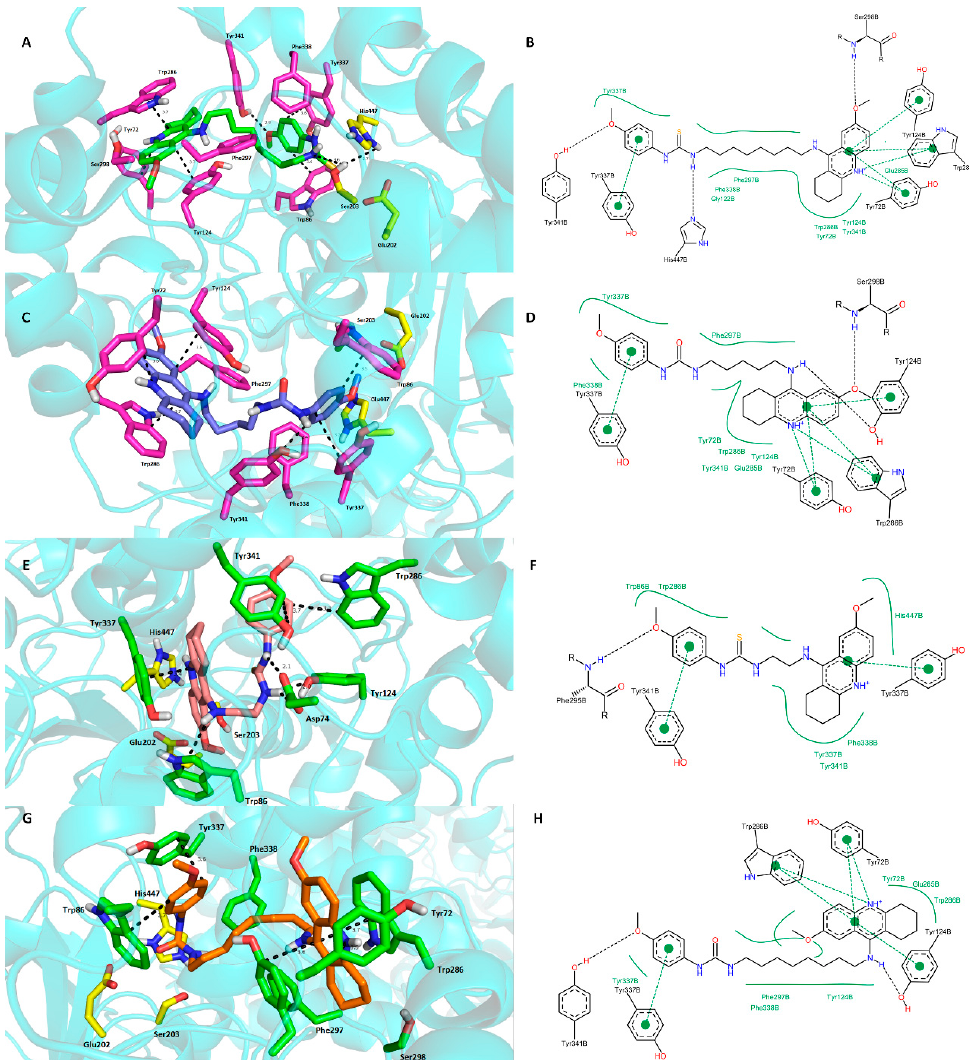
Figure 4 . Docking results for the novel 7-MEOTA- p -anisidine hybrids ( 9 , 15 , 19 and 22 ) within h AChE